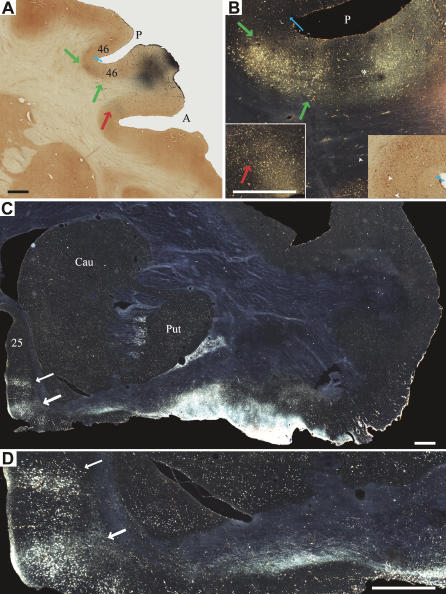
Examples of the Relationship of Projection Density to Axonal Trajectory(A) Low-power brightfield photomicrograph of a coronal section through the posterior prefrontal cortex of a rhesus monkey brain, showing the halo of an injection of HRP-WGA in ventral area 46, below the principal sulcus (dark area). Green arrows point to a projection site in area 46 in the depths of the lower bank of the principal sulcus (dark blotch). Another projection is found in the upper bank of the lower limb of the arcuate (“A”) sulcus (dark blotch, red arrow); axons from these projection sites can take a mildly deflected or straight course to the injection site.(B) Top: higher magnification under darkfield illumination of the depths and lower bank of the principal sulcus in the same section shows that the projection in ventral area 46 has many labeled neurons (gold, green arrows), and labeled axons (pink, white arrowhead) as they leave the halo of the injection site. Note that the dense projection abruptly terminates as the sulcus curves towards the upper bank of the principal sulcus, towards dorsal area 46. The magnified site at the lower right inset (blue arrow, brightfield illumination) shows only a few scattered labeled neurons in dorsal area 46 (white arrowheads), taken from the region with the corresponding blue arrows in (A, brightfield) and (B, darkfield). In contrast, the “straight” projection in the arcuate sulcus has many labeled neurons (lower left inset in [B], red arrow; darkfield illumination). The section was counterstained with neutral red.(C) Low-power darkfield photomicrograph of a coronal section through the caudal prefrontal cortex of a rhesus monkey brain showing the halo of the injection site in area OPAll/OPro (white area, bottom, center), and a resultant robust projection site of labeled neurons (white) arranged in a columnar pattern in area 25 (white arrows). The labeled fibers (white) around the putamen (Put) and in the internal capsule (interposed between the caudate and putamen, white) link the injection site with subcortical structures.(D) The columns of labeled neurons are shown at higher magnification. The inferiorly situated broad column of neurons (thick arrow) has a fairly straight course from the injection site, while the one above is deflected. Axons leaving the halo of the injection site are visible at this level (white fibers in white matter, which appears blue under darkfield illumination).Scale bars: (A), (C), 1 mm; (B), (D), 0.5 mm. Orientation axes: Medial, is to the left; dorsal, at the top.